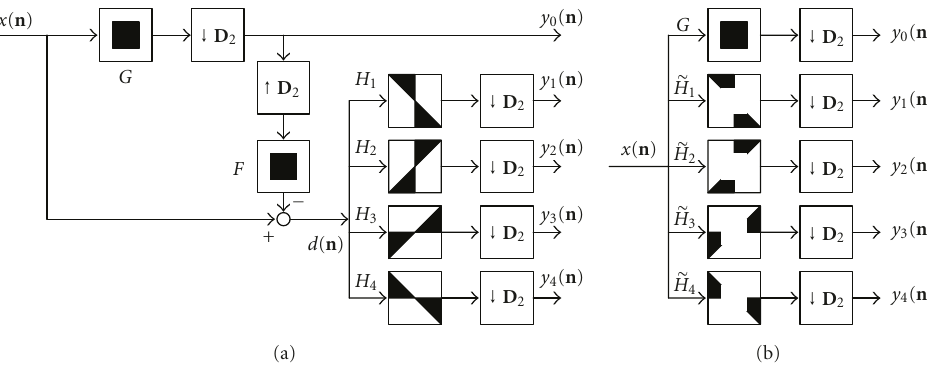
Figure 11: The four-band PDFB (a) the analysis side of the PDFB, (b) equivalent overcomplete FB, and (c) the synthesis FB.